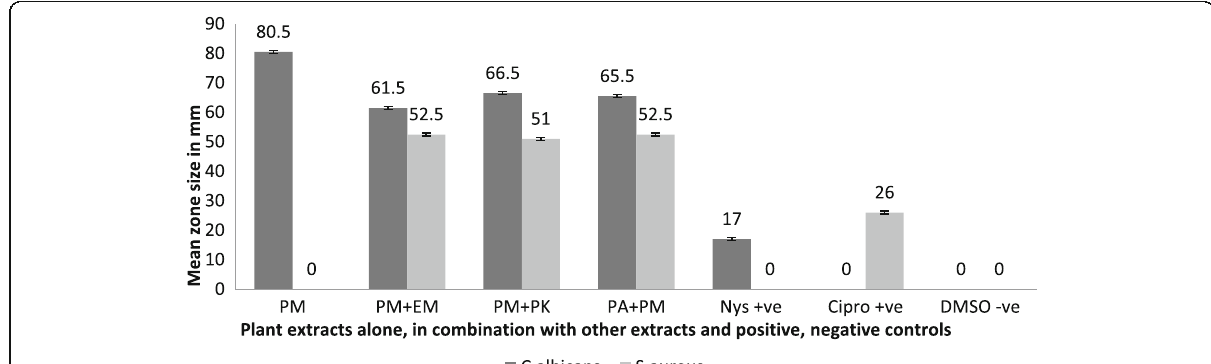
Fig. 3 Activity of Miswak alone and in combination with Aloe vera and Kalonji against S. aureus and C. albicans . Petroleum ether Miswak + Ethanol Miswak (PM+EM), Petroleum ether Miswak + Water Miswak (PM+EM), Petroleum ether Miswak + Petroleum ether Kalonji (PM+PK),